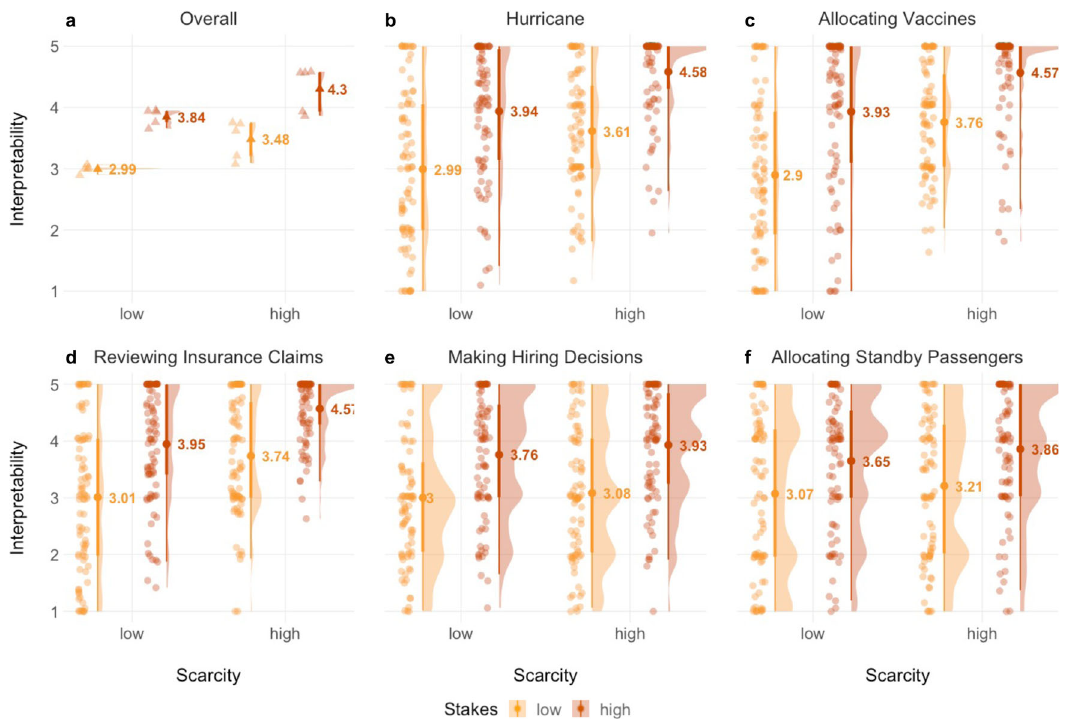
Fig. 3 | Results for Study 2. Participants ’ responses from Study 2 ( N =84) to the question “ In this case, how important is it that the AI is explainable? ” on a con- tinuous slider-scale from “ not at all important ” (1) to “ extremely important ” (5).All panelsshowthejitteredrawdata,itsdensity,thepointestimateofthemeanwithits 95%con fi denceintervals,andinterquartileranges;allgroupedbystakes(indicated by fi ll colour; low stakes=yellow, high stakes=red) and scarcity (indicated on x-